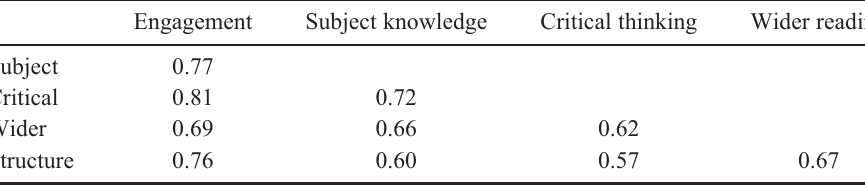
Table 5. Correlations for essay quality